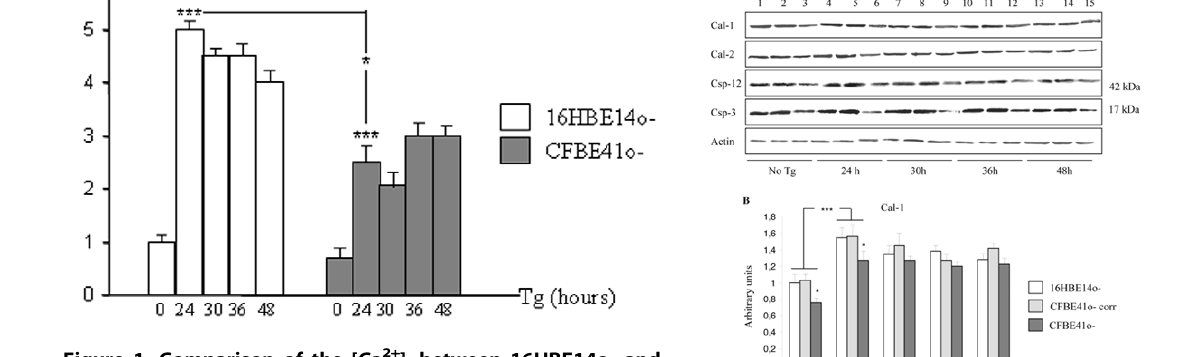
Figure 1. Comparison of the [Ca 2 + ] i between 16HBE14o- and CFBE41o- cells. 16HBE14o- and CFBE41o- cells were loaded with Fura- 2 AM and fluorescence was recorded at 340 nm (saturated calcium) and 380 nm (free calcium). The 340/380 nm ratio was calculated and compared between the two cell types at increasing times of Tg treatment. Whereas no significant difference was observed between the two cell types in the absence of Tg (0 time point), [Ca 2 + ] i was increased in 16HBE14o- and CFBE41o- cells after 24 hours treatment. A significant lower [Ca 2 + ] i was observed in the F508del-CFTR expressing cells. Bars represent SEM (n=9). doi:10.1371/journal.pone.0008436.g001 CFBE41o- and corrected CFBE41o- cells (CFBE41o- corr, Fig. 2A). The statistical analysis (Fig. 2B) showed that basal Cal-1, Csp-12 and Csp-3 expressions were decreased in CFBE41o- cells, whereas the Cal-2 expression was not modified. After 24, 30, 36 and 48 hours of ER stress due to Tg, Cal-1, Cal-2, Csp-12, Csp-3 expressions were assessed in the three cell types using western blottings (Fig. 3A). Cal-1 expression was increased in all the cell types after 24 hours treatment and remained higher than in the